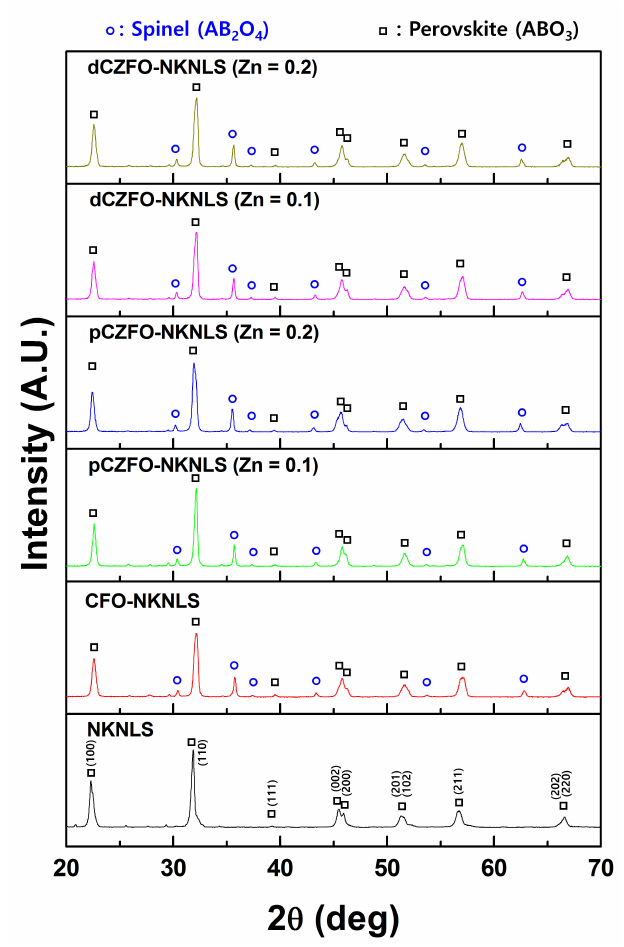
Figure 4. XRD patterns of magnetoelectric (ME) particulate composites consisting of a piezoelectric phase of NKNLS and magnetostrictive phases of CFO, pCZFO (Zn = 0.1, 0.2) and dCZFO (Zn = 0.1, 0.2). From the particulate composites of CFO-NKNLS, pCZFO-NKNLS (Zn = 0.1, 0.2), and dCZFO-NKNLS (Zn = 0.1, 0.2), ME voltage ( α ME ) and H opt. were investigated while applying H ac = 1